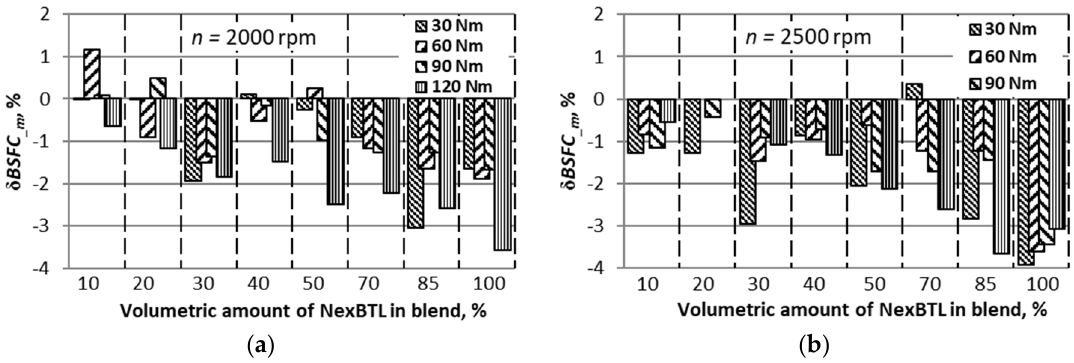
Figure 8. Relative deviation of BSFC according to mass fuel consumption [g/kWh]: ( a ) n = 2000 rpm; ( b ) n = 2500 rpm.